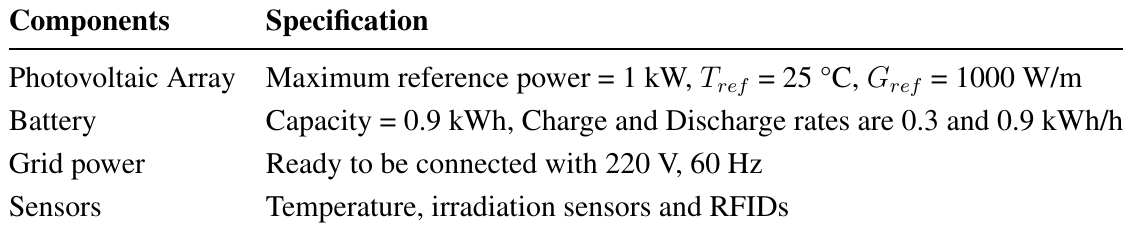
Table 1. System components specifications.